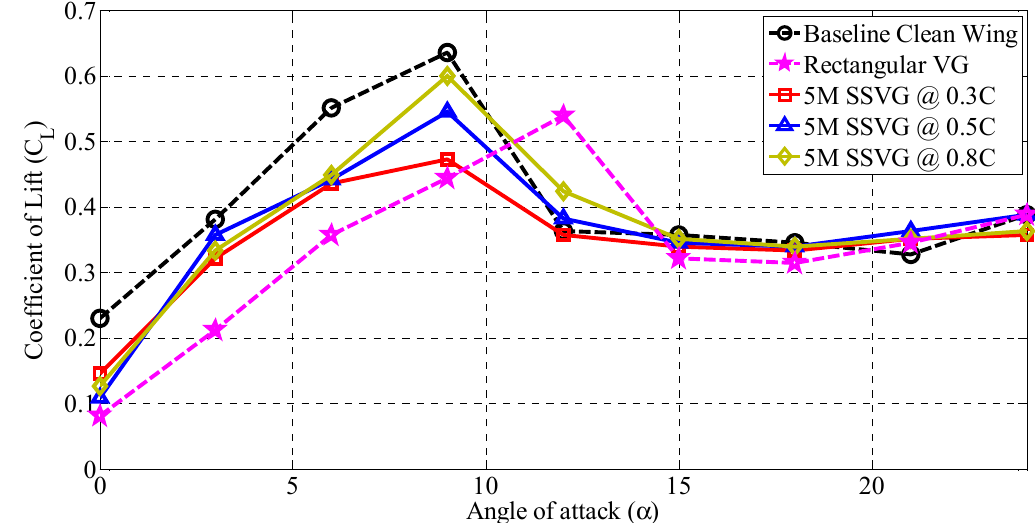
Figure 12. Coefficient of lift ( C L ) vs. angle of attack ( α ) for the baseline and modified model with medium-sized (5M) shark scale vortex generators (SSVG).